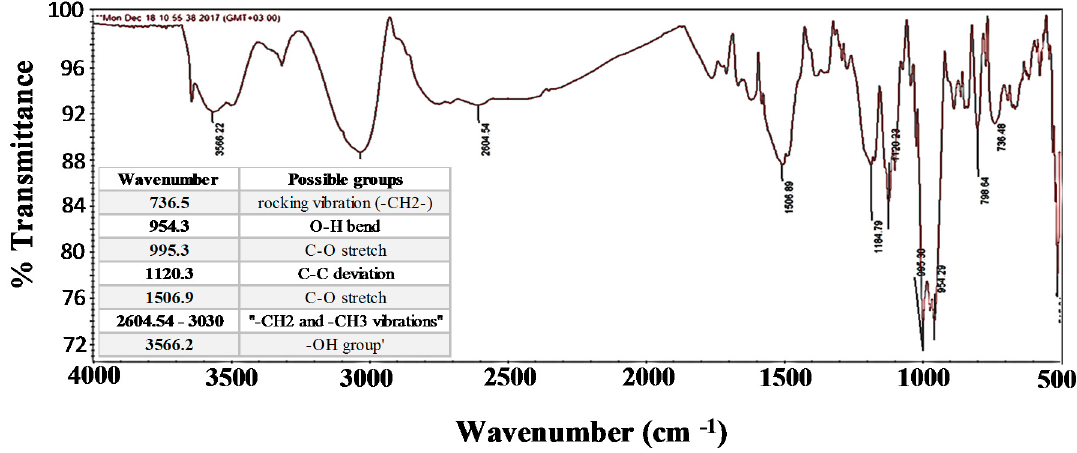
Figure 2. FT-IR transmittance spectra of DPFS.